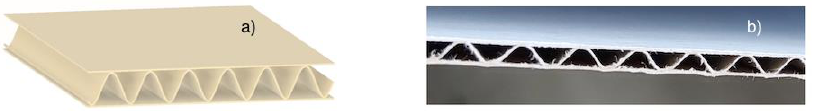
Table 1. Mechanical specification of the B-flute corrugated cardboard tested.